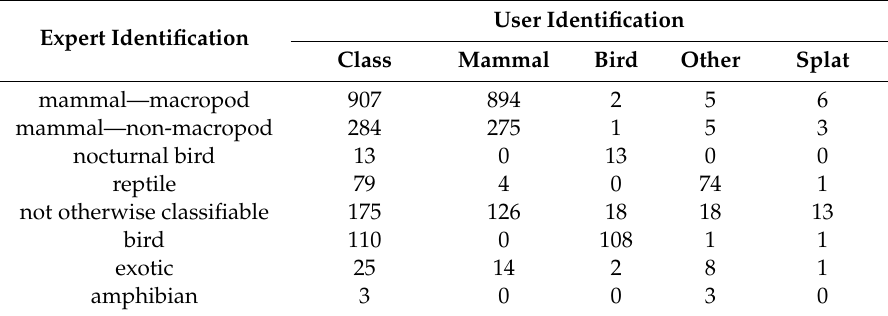
Table 3. Experts’ identification of roadkill from photographs and how RRApp users identified those same